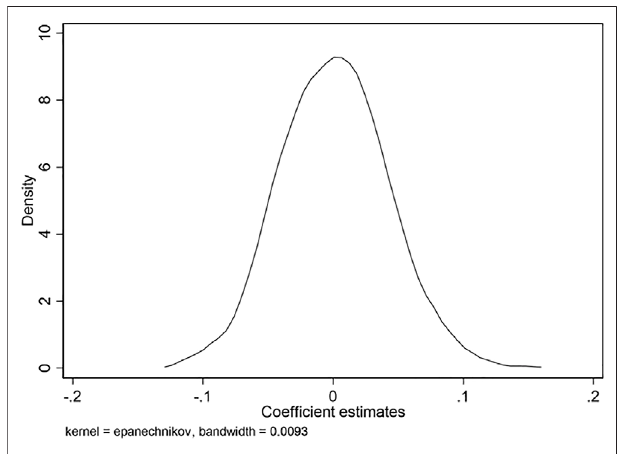
FIGURE 5 | Kernel density diagram for HSR opening